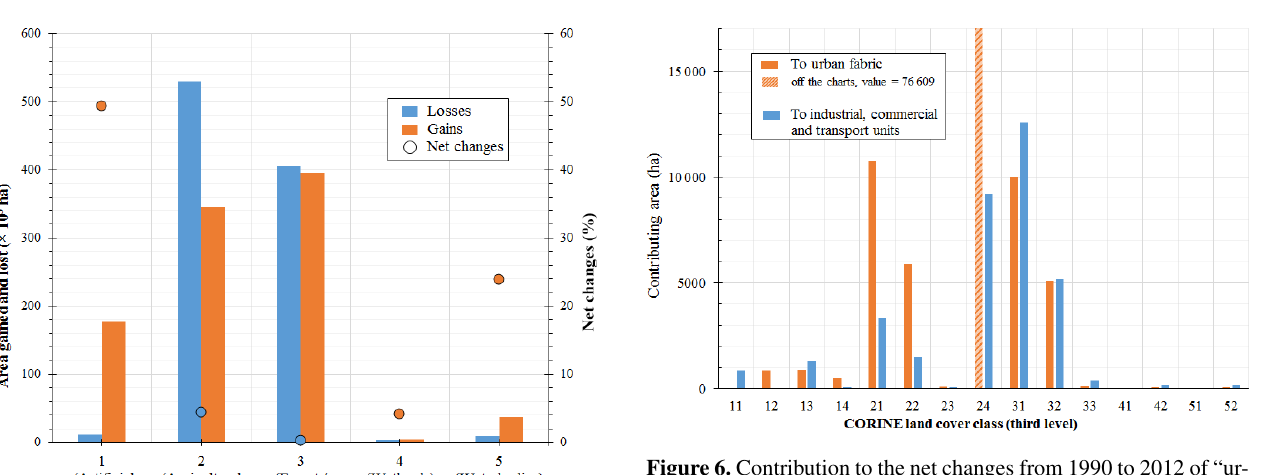
Figure 6. Contribution to the net changes from 1990 to 2012 of “ur- ban fabric” (orange bars) and “industrial, commercial and transport” (blue bars) from the other CLC